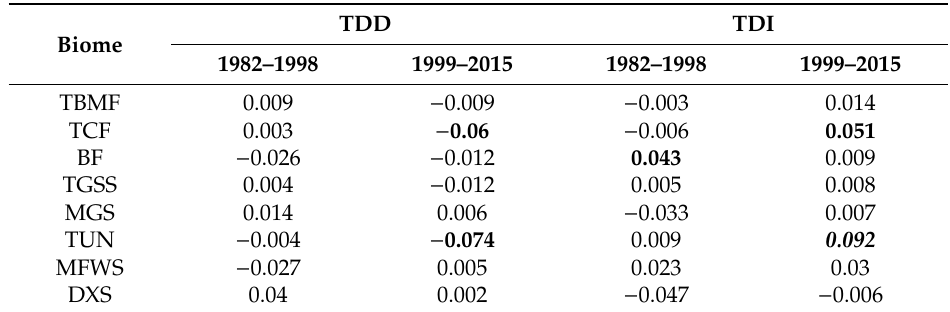
Table 1. Interannual variations in total drought duration (TDD) and total drought intensity (TDI) at the biome level during the 1982–1998 and 1999–2015 periods, respectively 1